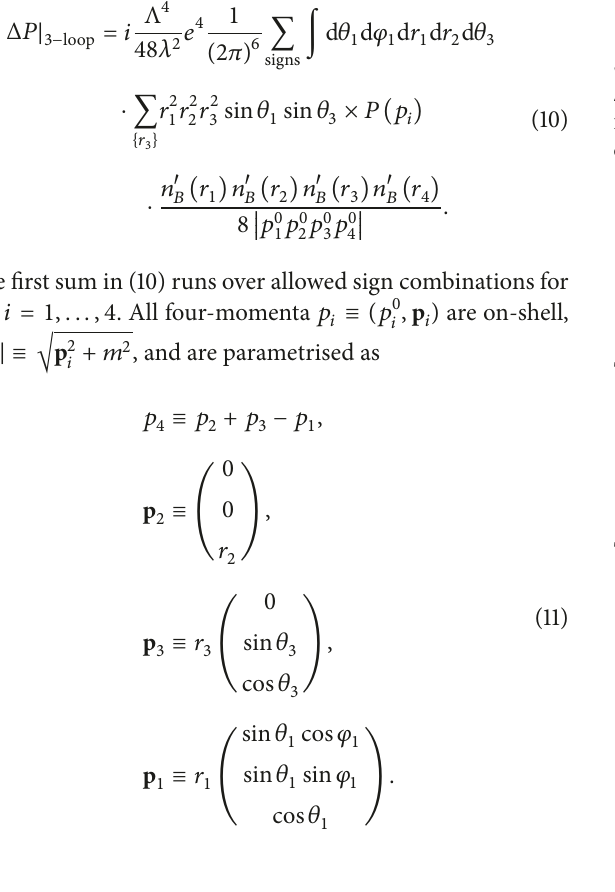
𝑃| 1− loop . In (b), the continuous curves represent the analytical high-